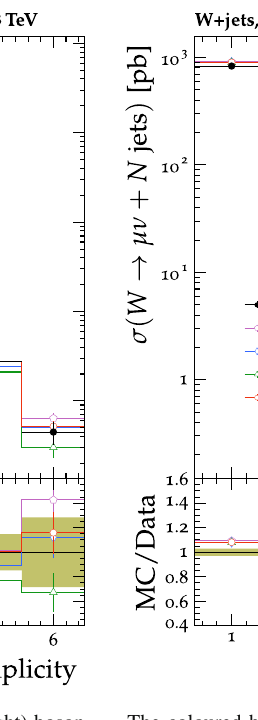
Fig. 18 The exclusive jet multiplicity in Z(left) and W(right) boson The coloured band in the ratio plot represents the total experimental √ s = 13TeV [46,47]. CMS Zboson events, measured by CMS at uncertainty in the data. The vertical bars on the points for the different predictions represent the statistical uncertainties and Wboson data are compared with the predictions from Mad- Graph 5_a mc@nlo + herwig 7, with the SoftTune and CH tunes. Fig. 14. The variables presented are the charged-particle